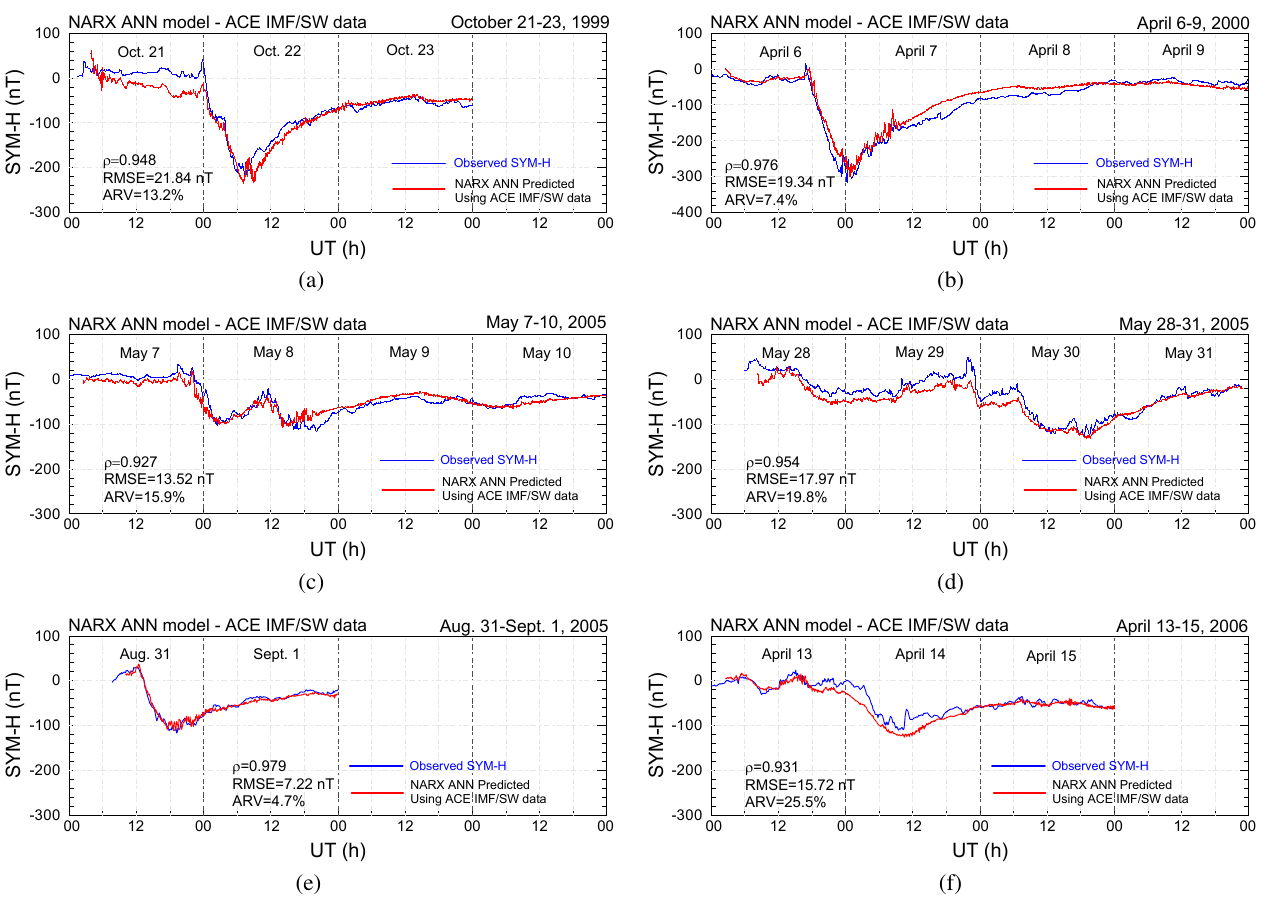
(b) Fig. 5. Prediction performance by NARX network versus feedback delay time length of L . (a) For L value from 0 to 24 hours; (b) A zoom-in